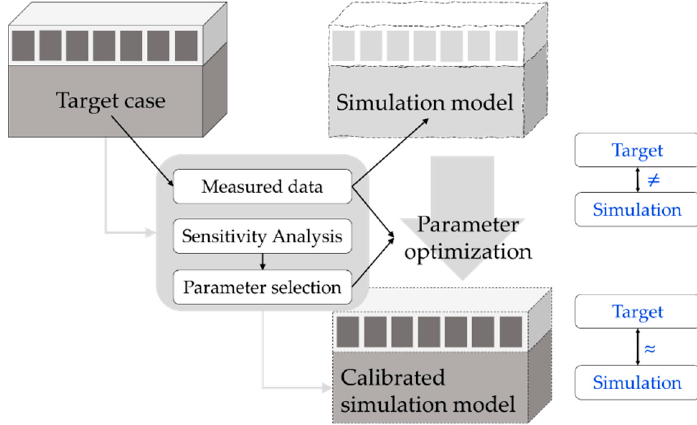
Figure 1. Concept diagram of the proposed methodology for developing a calibrated model.